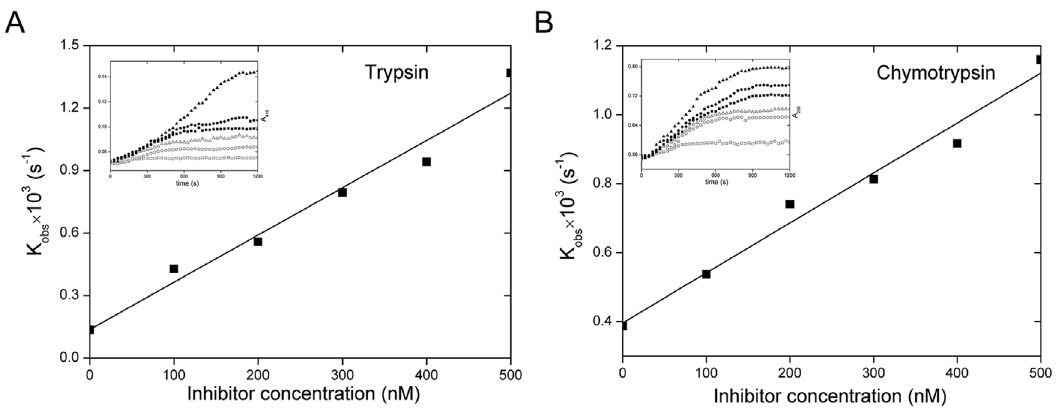
N Figure 2. Determination of association rate constant. (A) Trypsin (8 nM) was added to a mixture of 760 m M BAPNA and SW-AT-1 at 0 ( % ), 100 N ) and 500( m ) nM. (B) Chymotrypsin (8 nM) was added to a mixture of 250 m M BTEE and SW-AT-1 at 0 ( % ), 100 ( # ), 200 ( # ), 200 ( D ), 300 ( & ), 400 ( ) and 500( m ) nM. The progress of enzyme inactivation ( inset ) was followed by measuring absorbance at 410 nm and 256nm on a ( D ), 300 ( & ), 400 ( microplate reader. Pseudo-first-order rate constants of inhibition ( k obs ) were plotted as a function of SW-AT-1 concentration ([I]).